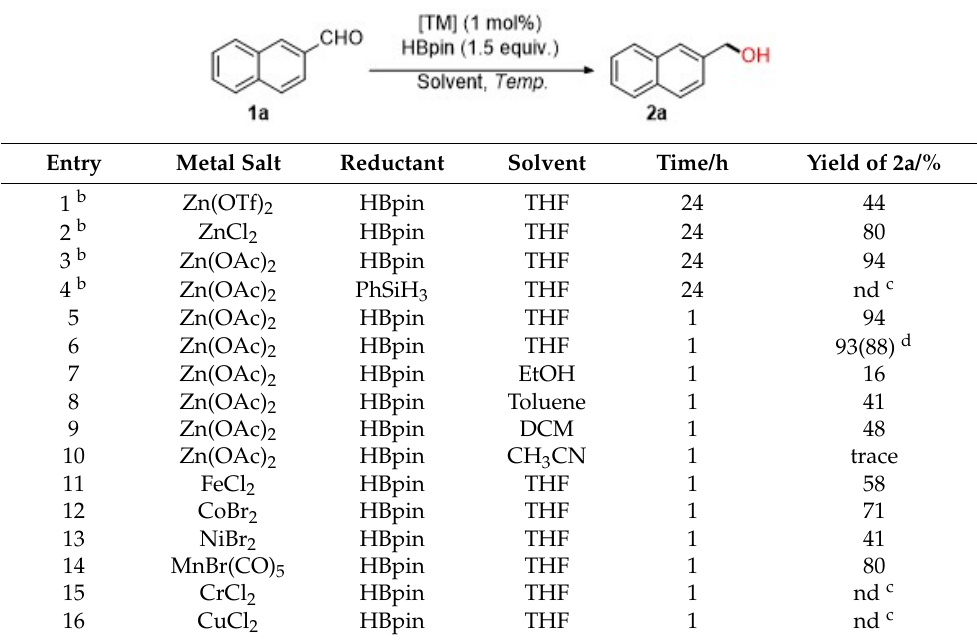
Table 1. Reaction optimization for the Zn-catalyzed reduction of 2-naphthaldehyde a .